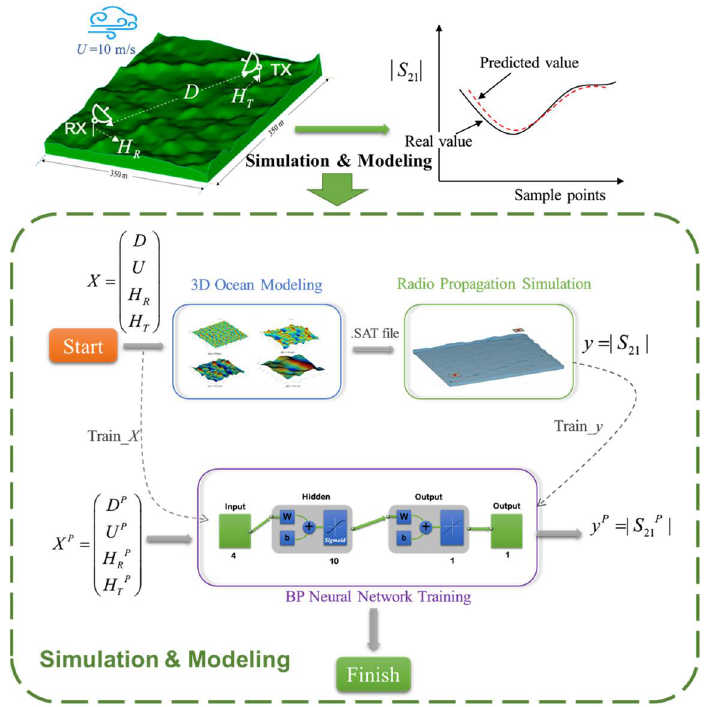
Figure 1. The schematic illustration of the work, where D means antenna distance, H R , H T are height of receiving antenna (RX) and transmitting antenna (TX), U is wind speed, and S 21 is radio propagation loss. X stands for training input; y represents training target. X P is the prediction input, y P is the prediction response.